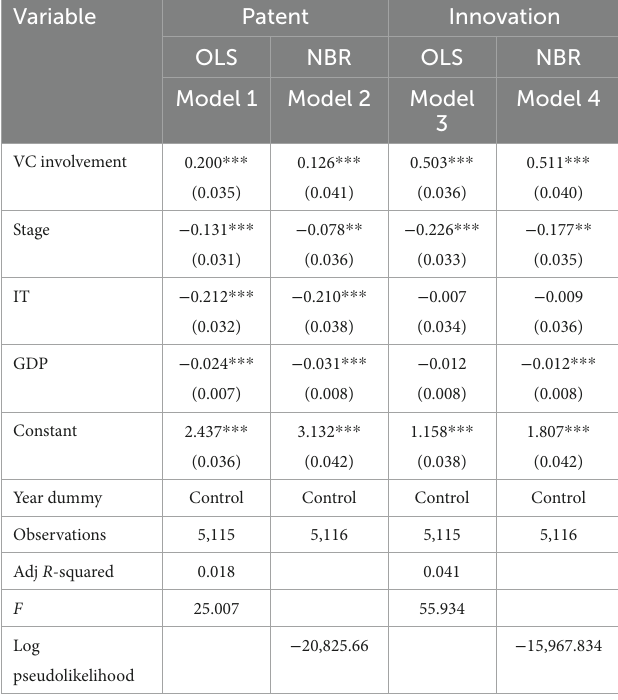
TABLE 3 The impact of venture capital involvement on enterprise innovation